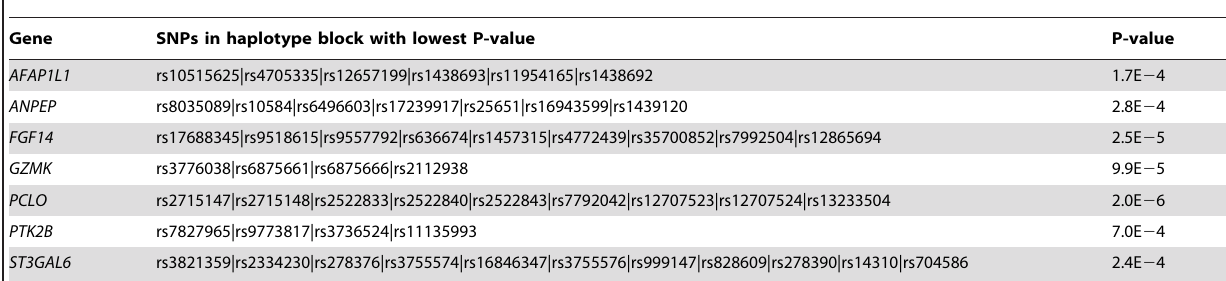
Table 4. The haplotypes with the lowest P-values, per gene.